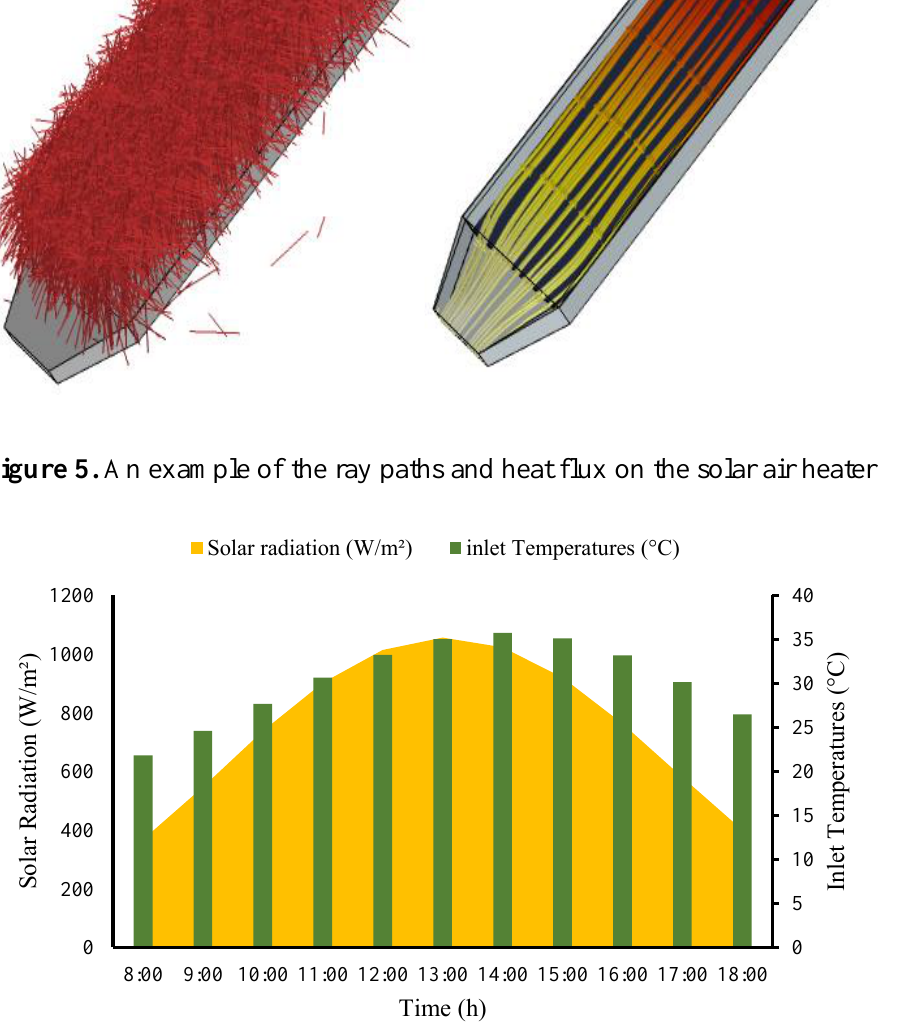
Figure 6. On a typical day in July, in Yasouj, Iran, ambient air temperature and solar irradiation